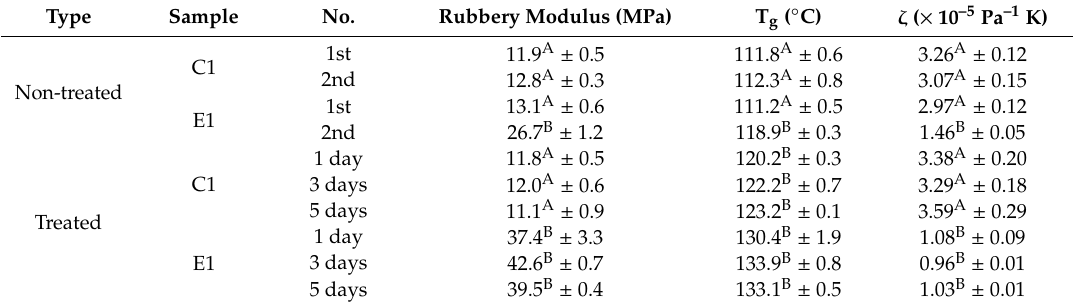
Table 2. Rubbery modulus, T g , and crosslinking density of the C1 and E1 specimens.